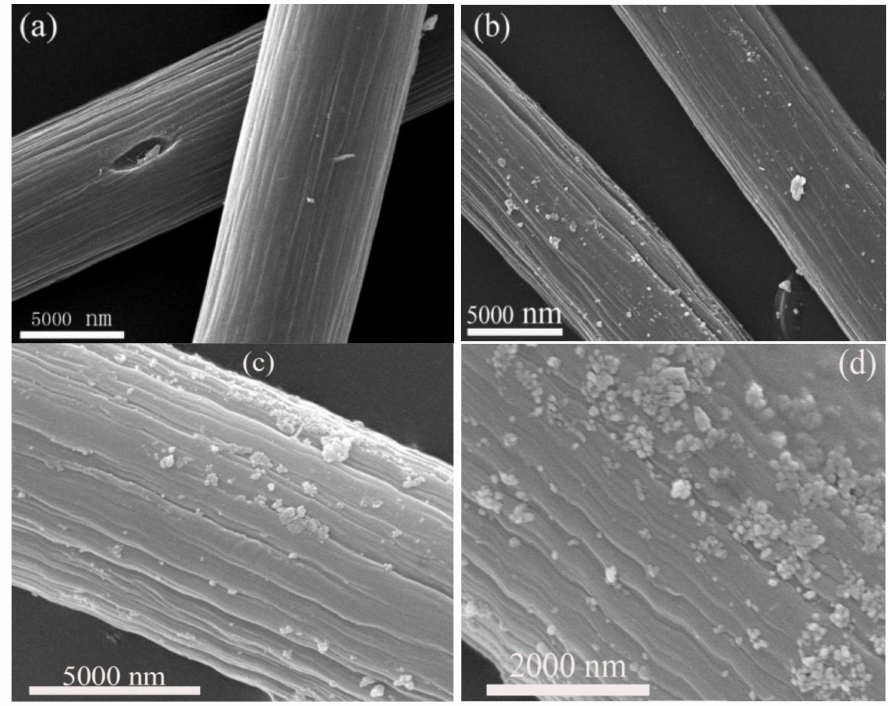
Figure 4. SEM image of ACFN ( a ) and ACFN with loading different MnO 2 amounts: ( b ) 5 wt%, ( c ) 8 wt%, and ( d ) 10